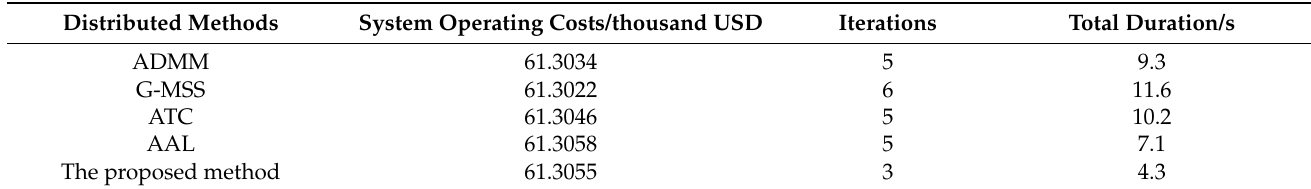
Table 8. Comparison of the results of different distributed algorithms to solve test case